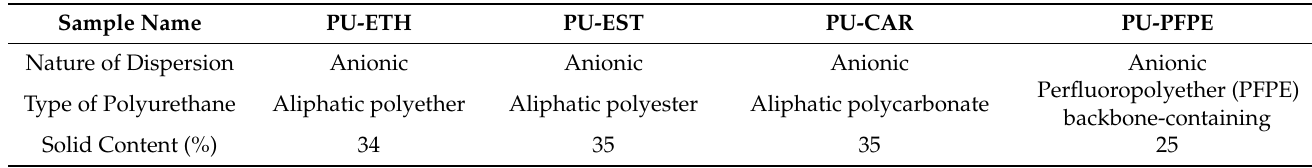
Table 1. Technical datasheet of the chosen commercial dispersions.